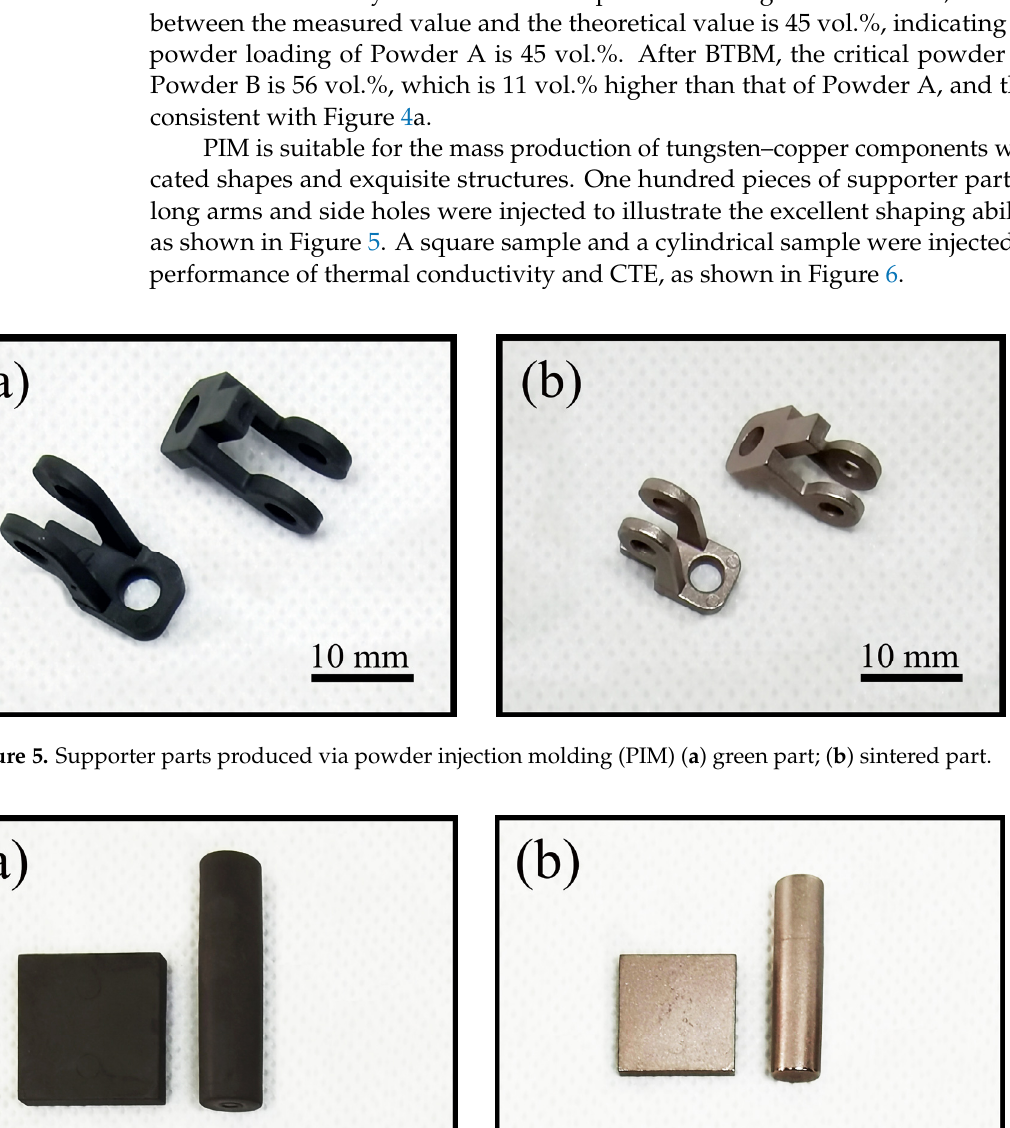
Figure 4. ( a ) Mixing torque of feedstock variation with the powder loading; ( b ) density of feedstock variation with the powder loading.